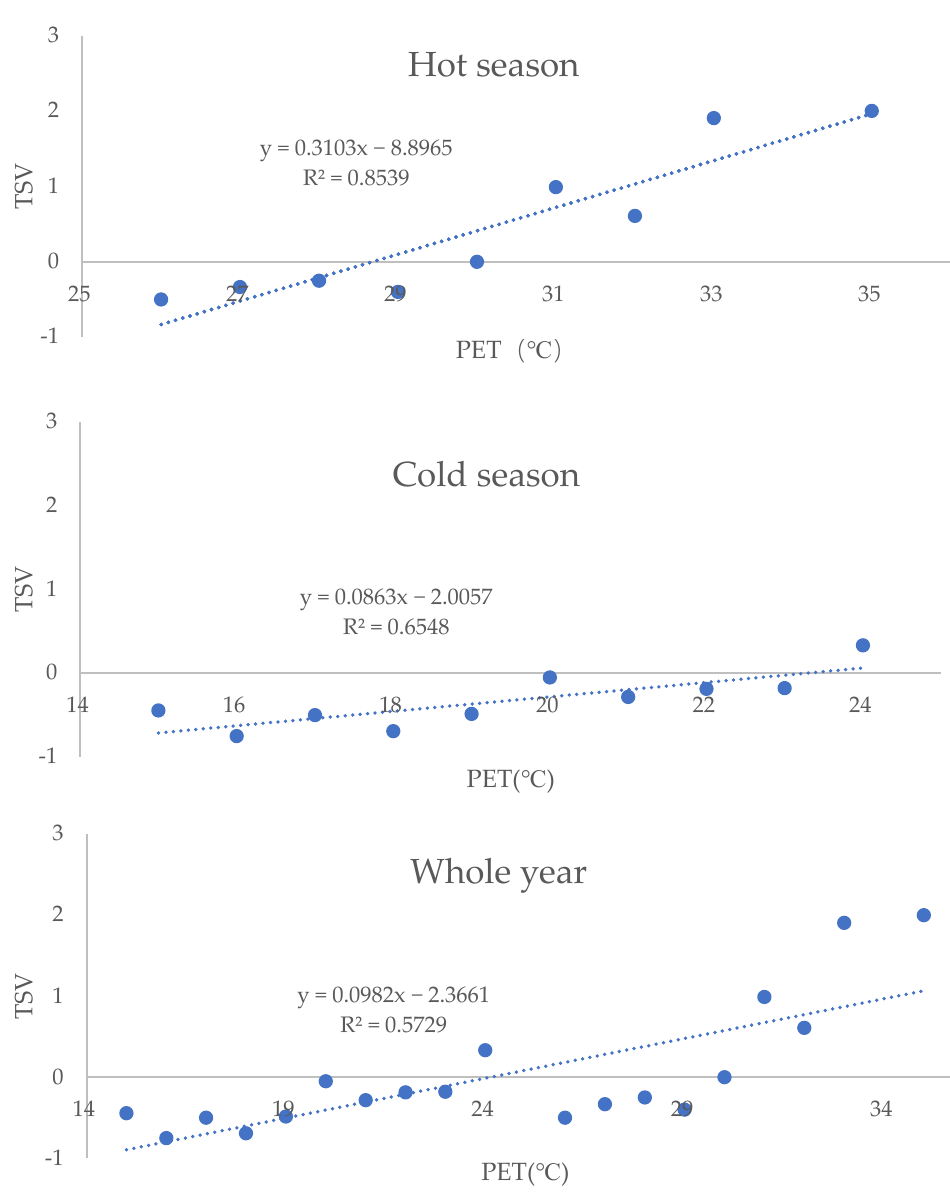
Figure 5. Relationship between TSV and PET.